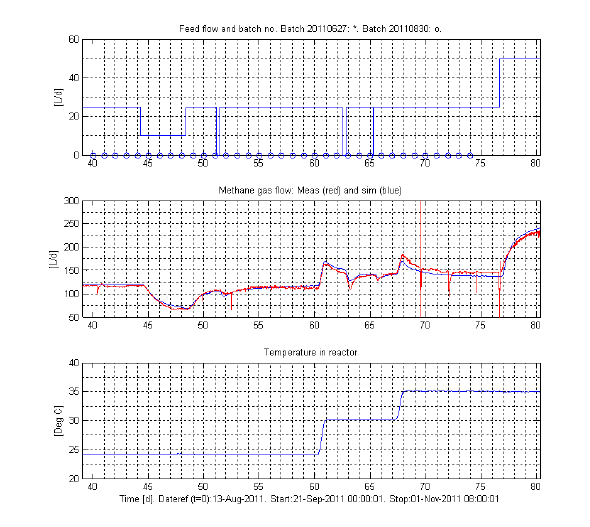
Figure 2: Reactor ADR1: Responses in F meth (middle) due to changes in T reac (lower) and F feed (up- per). For F meth : Measured is blue. Simula- tion is red. [This plot also appears in Haugen et al.